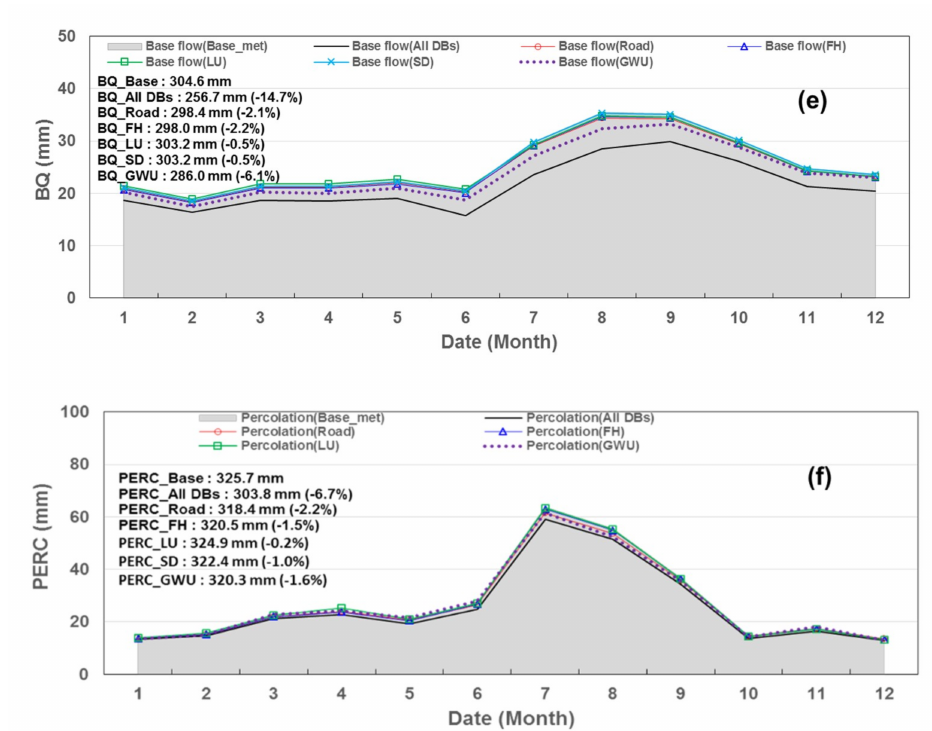
Figure 4. Comparison graphs of the monthly results of the water budgets after applying each water loss DB: ( a ) total runoff (TQ), ( b ) evapotranspiration (ET), ( c ) surface runoff (SQ), ( d ) lateral runoff (LQ), ( e ) base flow (BQ) and ( f ) percolation